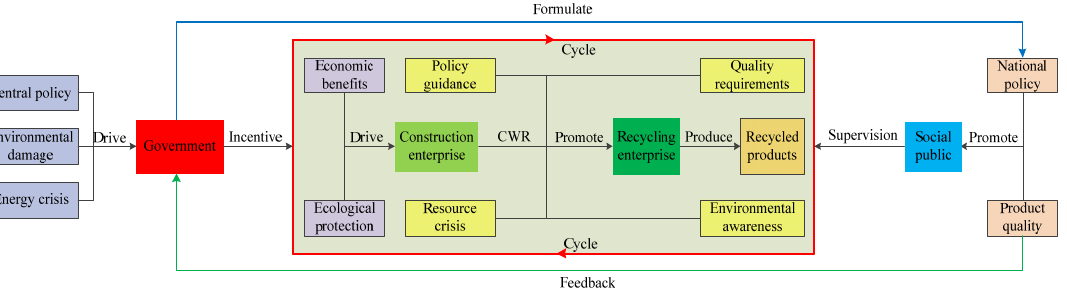
Figure 3. The core stakeholder relationship model of